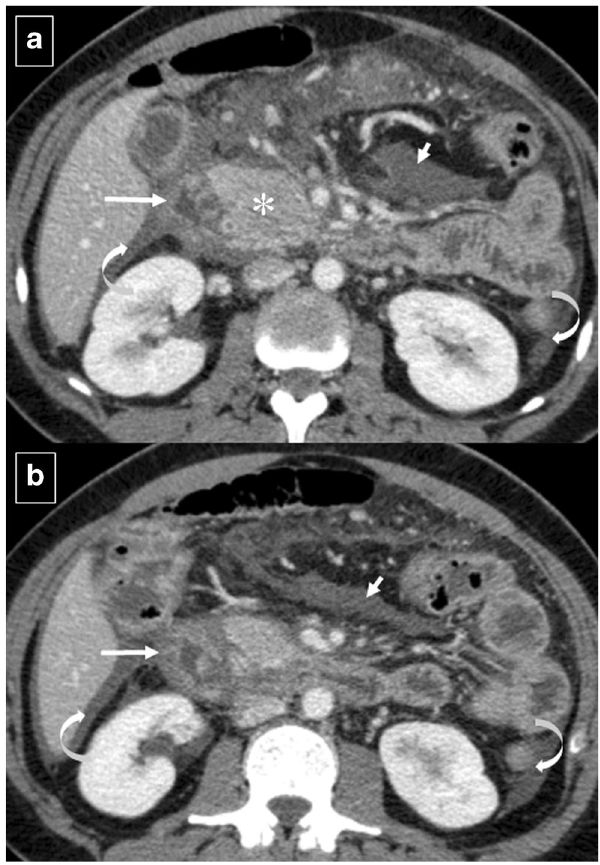
Fig. 13 Acute exsudative pancreatitis and duodenal edema in a 50-year- old man. Contrast-enhanced CT shows an enlarged pancreatic head (*) with stranding of the peripancreatic fat and peripancreatic fluid (short arrows). The wall of the duodenum is thickened, and limited mural enhancement is seen secondary to edema (arrows). Also note the pathologic amount of fluid in the upper abdomen (curved arrows)